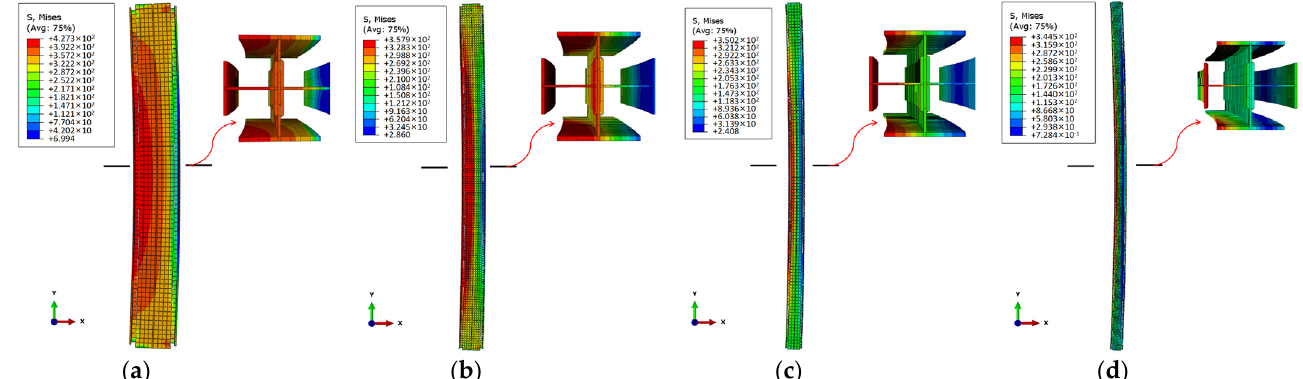
Figure 8. The FCHC-1-7 series illustrates the typical failure mode of the flexural-torsional buckling: ( a ) FCHC-1-7-3; ( b ) FCHC-1-7-6; ( c ) FCHC-1-7-9; ( d ) FCHC-1-7-12.